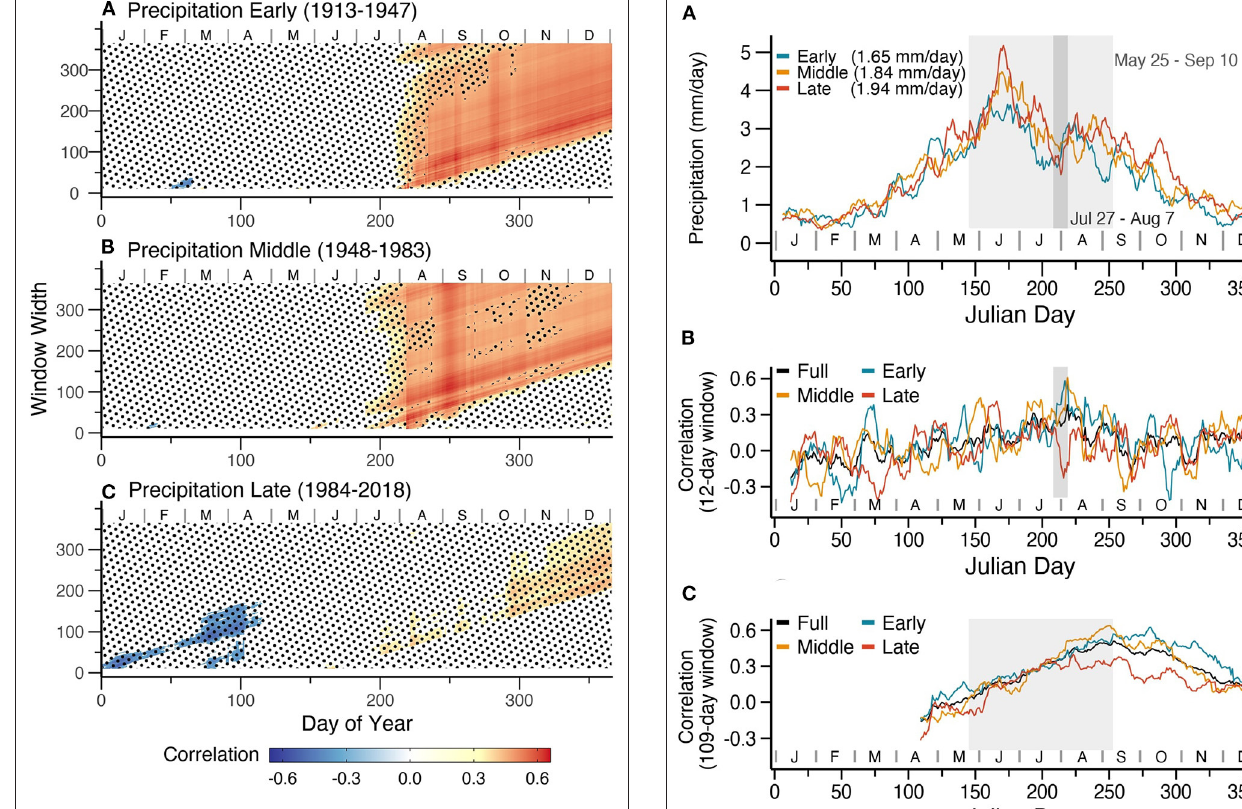
using the daily_response() function, differed between the early ( r = 0.651; June 21 to September 10), middle ( r = 0.658; July 27 to August 6), and late ( r = 0.458; June 6 to June 15) periods.